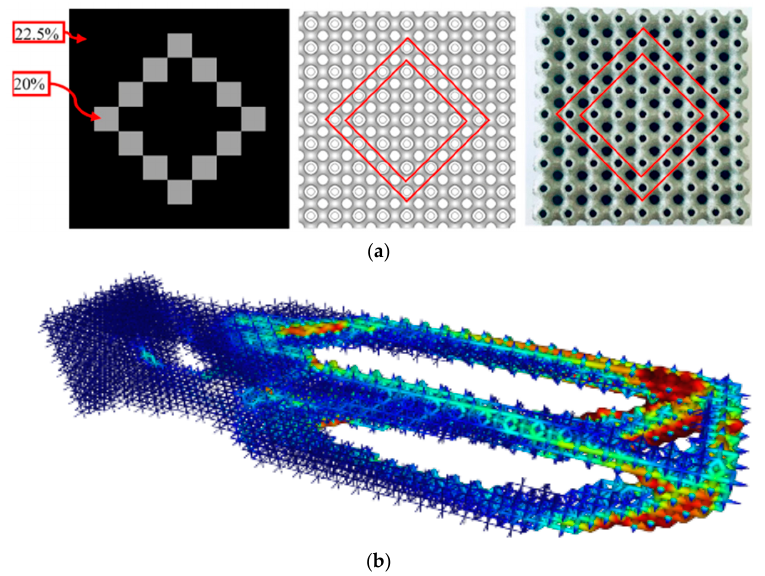
Figure 4. Two approaches to implementing gradation in prescribed regions: ( a ) a priori identification of regions with specific relative density targets of 20 and 22.5% shown, reproduced from [19] (CC BY license); ( b ) simulation-obtained field-driven thickening of lattice struts, with colors corresponding to von-Mises stress (authors’